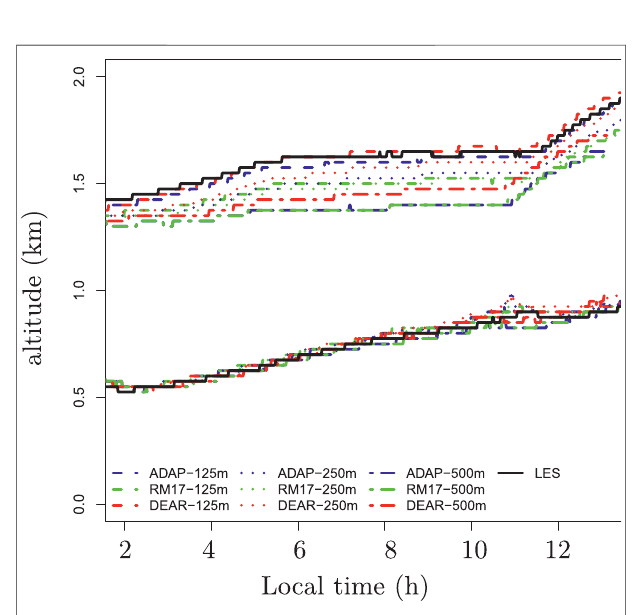
FIGURE 9 | Temporal evolution of the cloud base and cloud top in CONSTRAINwithDEAR,RM17and L (red, greenand bluelines,respectively) at 125, 250, and 500 m grid spacing (full, dashed and dotted lines, respectively).